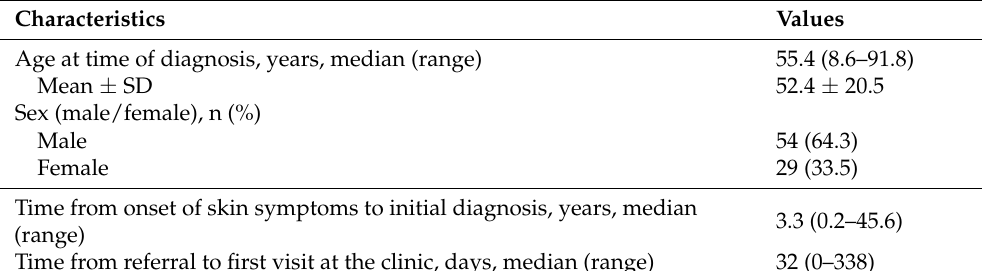
Table 1. Summary of demographic and clinical characteristics of 84 patients with mycosis fungoides.